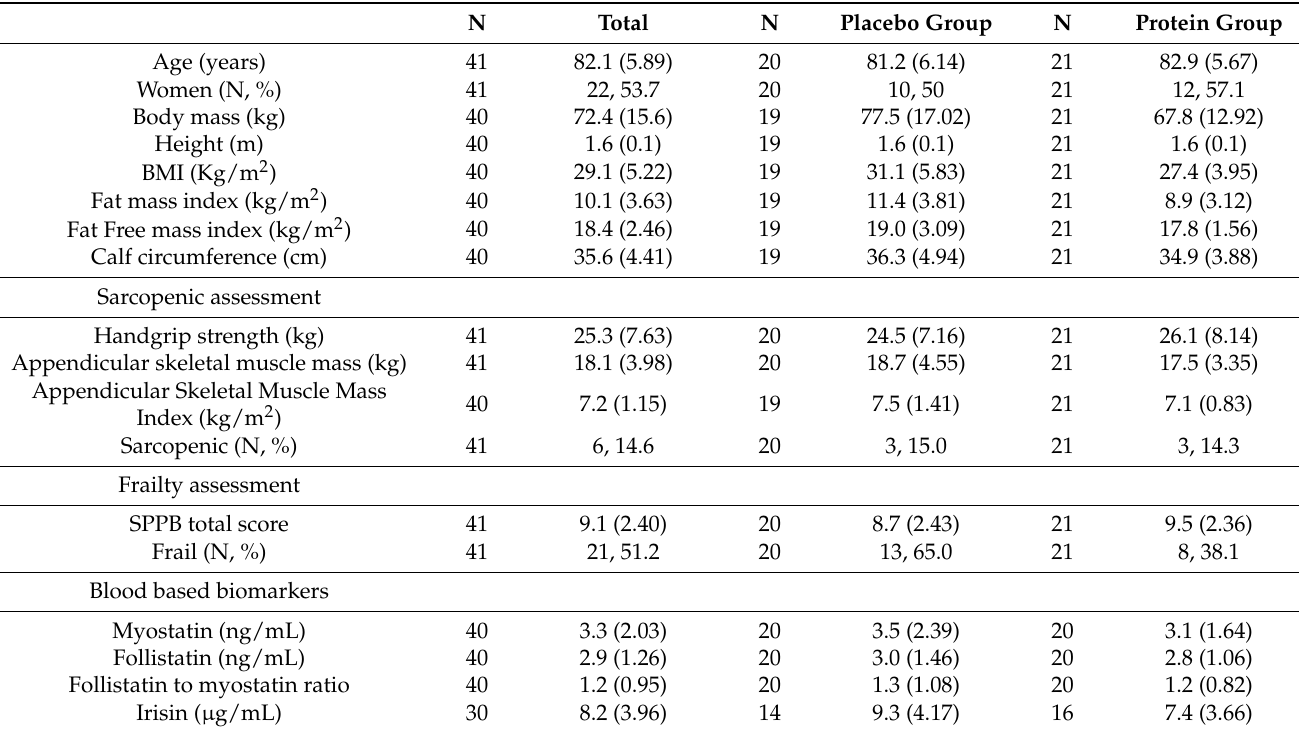
Table 1. Characte.2istics of participants in the study at